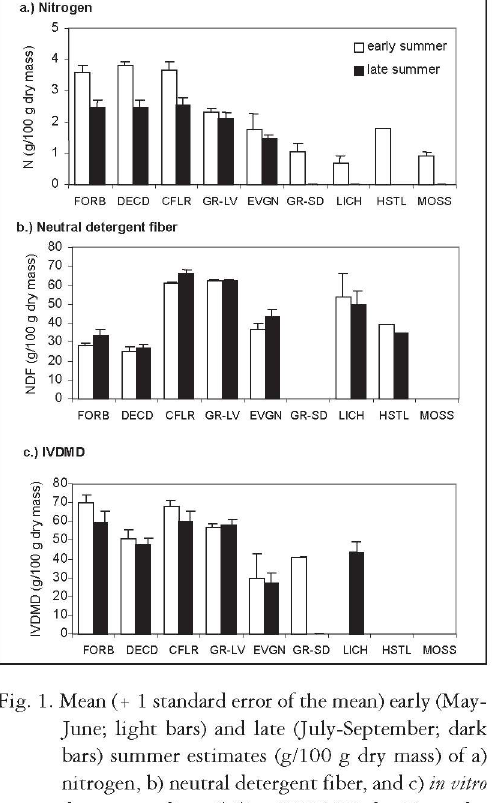
Fig. 1. Mean (+ 1 standard error of the mean) early (May- June; light bars) and late (July-September; dark bars) summer estimates (g/100 g dry mass) of a) nitrogen, b) neutral detergent fiber, and c) in vitro dry matter digestibility (IVDMD) for 10 tundra FORB = forbs, DECD=deciduous shrubs, CFLR= cottongrass flower, GR-LV=graminoids live,